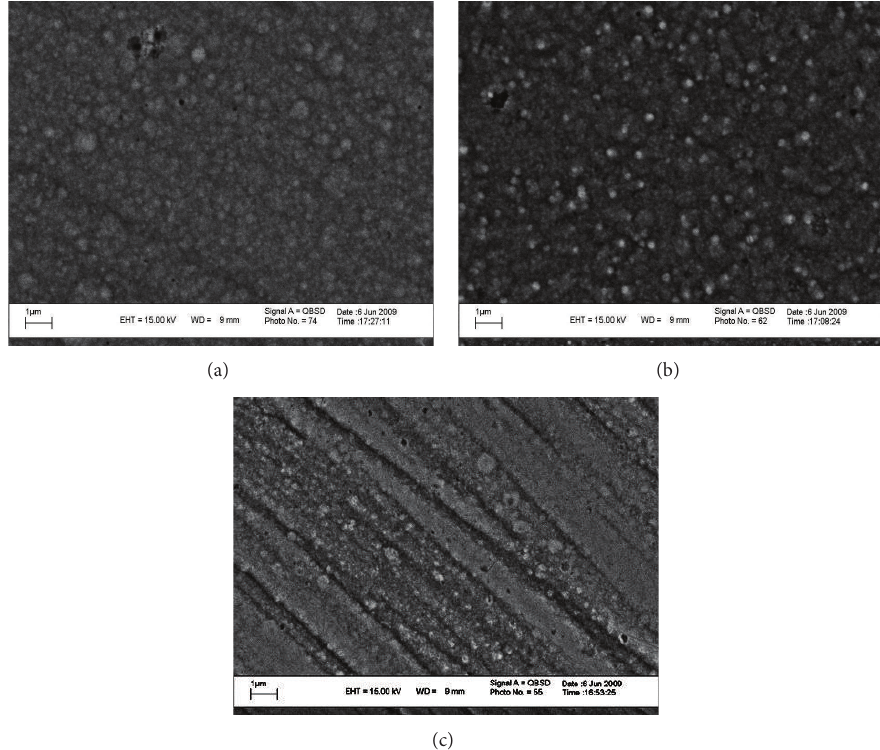
Figure 6: SEM images of Ni-Cu-P-Al 2 O 3 electroless composite coatings obtained from plating bath containing different concentration of nano-Al 2 O 3 particles: (a) 5 ppm, (b) 20 ppm, and (c)